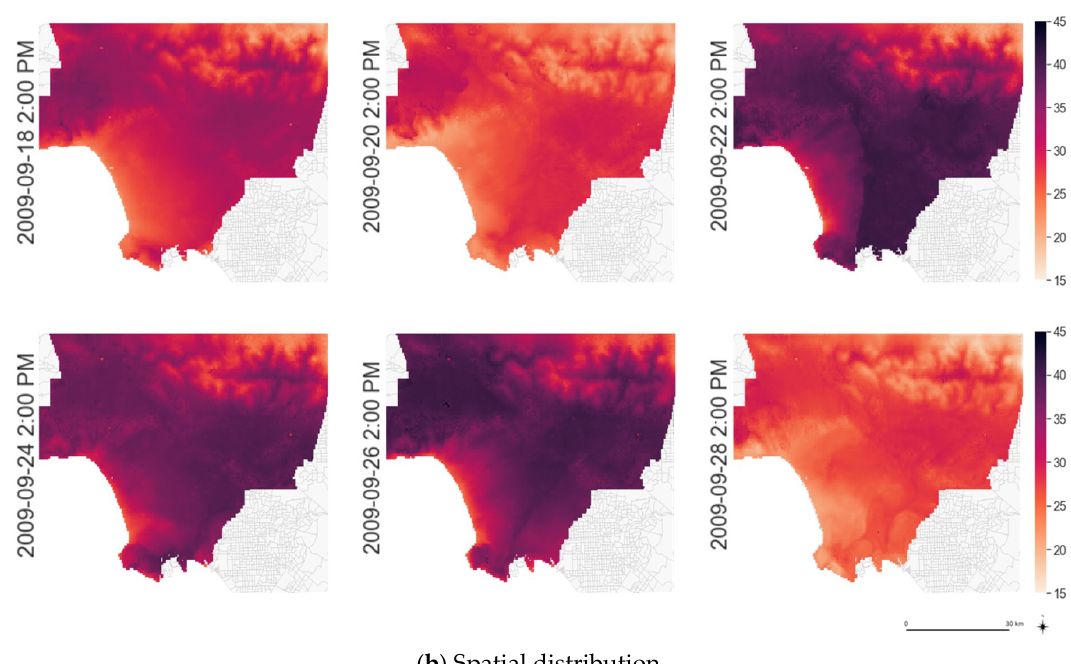
Figure 8. Dry‐bulb temperature (°C) distribution during the heat wave. ( a ): Temporal variation (averaged over all grids), ( b ) Spatial distribution.